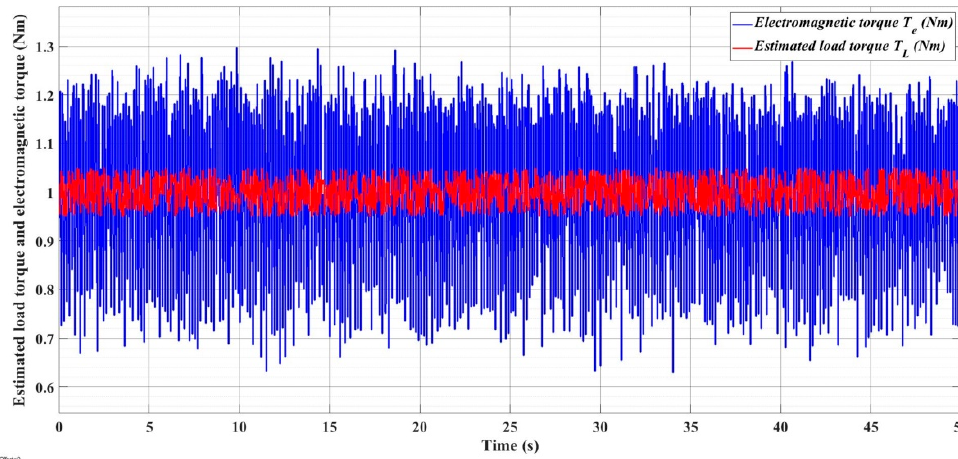
Figure 41. Real-time evolution for the estimate load torque and electromagnetic torque of PMSM— HIL stage; ω ref = 1600 rpm and T L = 1 Nm.